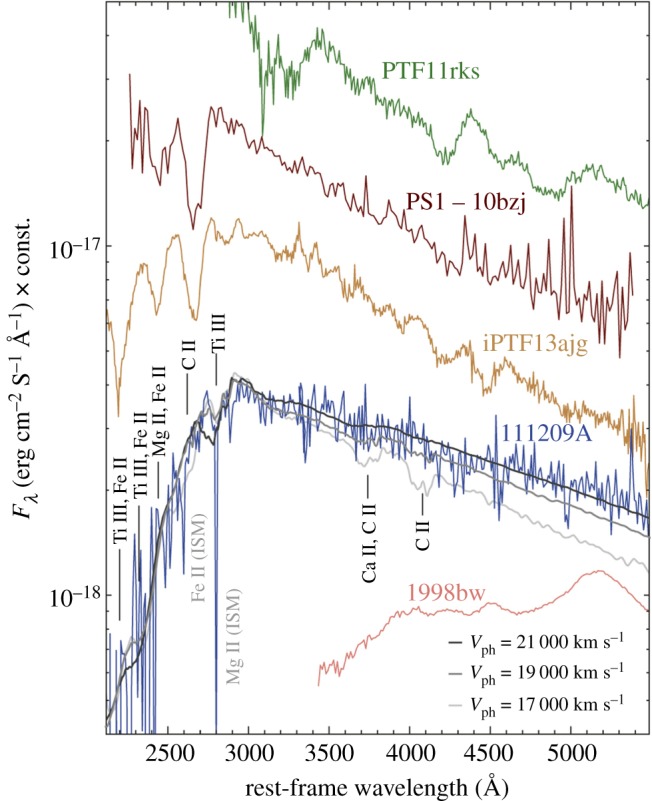
The X-shooter spectrum of SN 2011kl, associated with GRB 111209A, compared to the archetypal GRB–SN, SN 1998bw (pink), and spectra of three well-known SLSNe (top three curves). The three solid lines correspond to synthetic spectra with photospheric velocities of 21 000, 19 000 and 17 000 km s−1, going from darkest to lightest grey. The flux scale is correct for SN 2011kl and SN 1998bw, but all other spectra have been arbitrarily shifted for clarity [39].